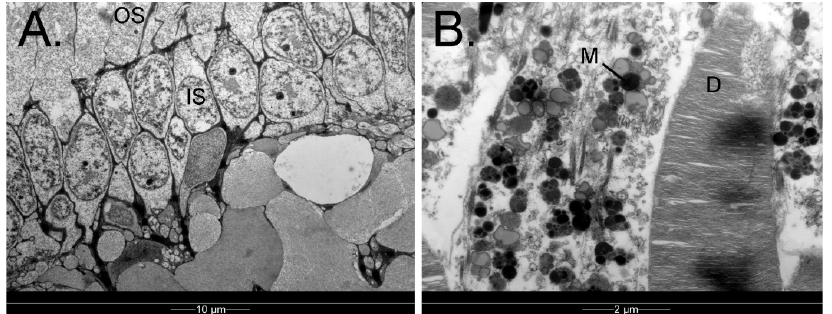
Figure 9. Retina of the king penguin Aptenodytes patagonicus , as imaged with transmission electron microscopy. ( A ) Both outer segments (OS) and inner segments (IS) of the retinal photoreceptors are approximately 6–7 mm apart; ( B ) The photoreceptor outer segments, which contain discs (D) wherein phototransduction takes place, are surrounded by melanosome-laden retinal pigment epithelial cells (M). Credit: PWH.